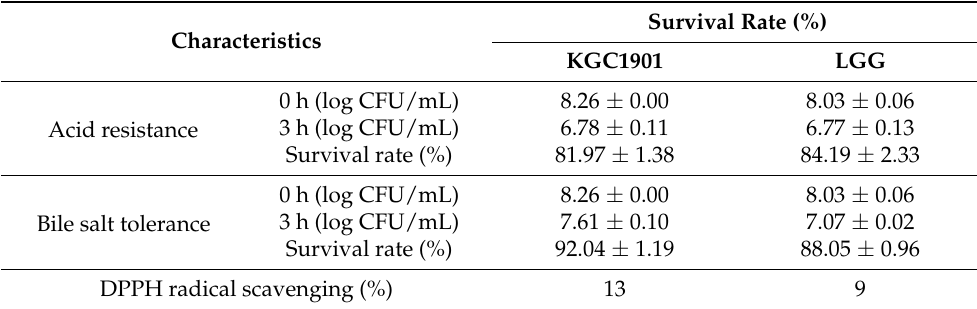
Table 4. Acid resistance, bile salt tolerance, and antioxidant activity of L. reuteri KGC1901. Data are presented as mean ± standard deviation values from triplicate experiments.